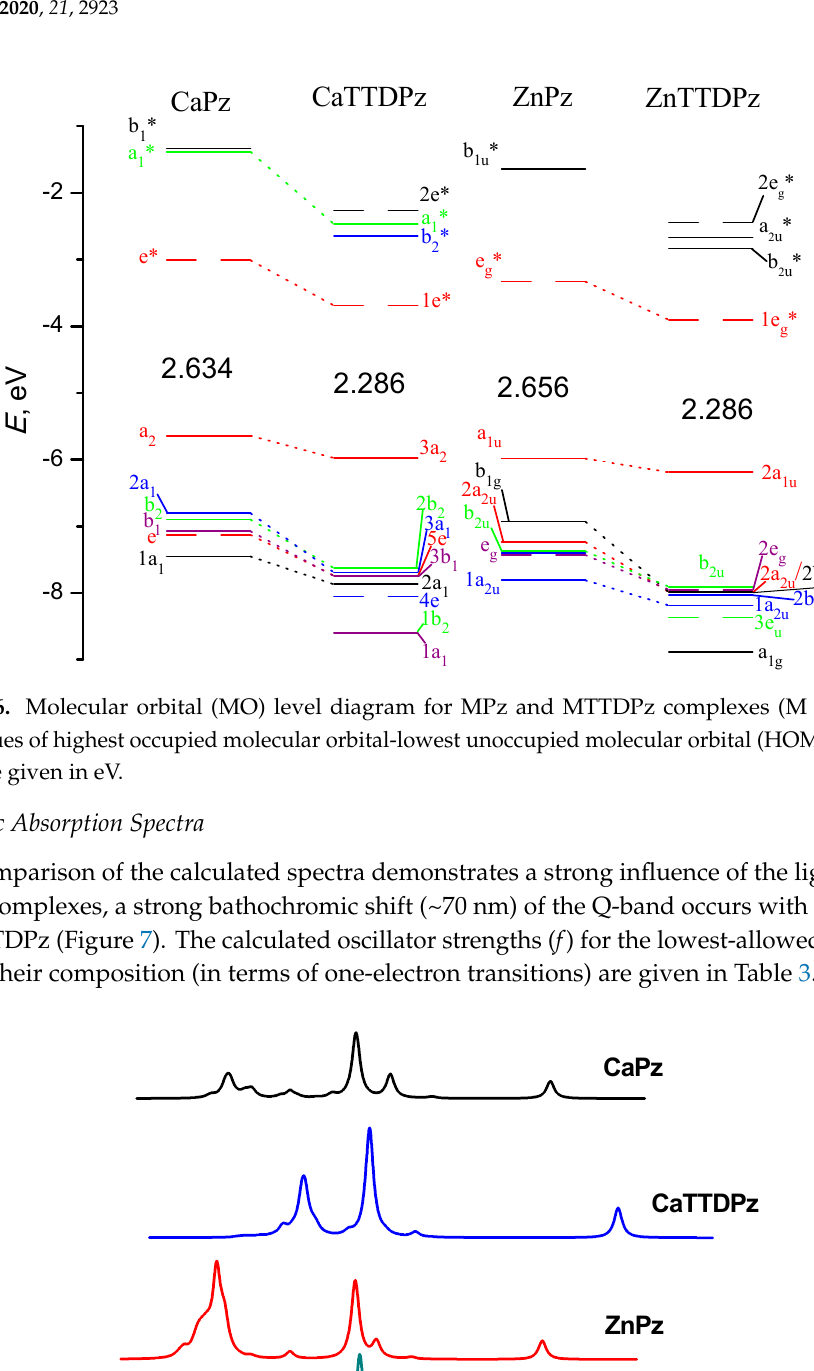
Figure 7 . Calculated TDDFT electronic absorption spectra for MPz and MTTDPz complexes.